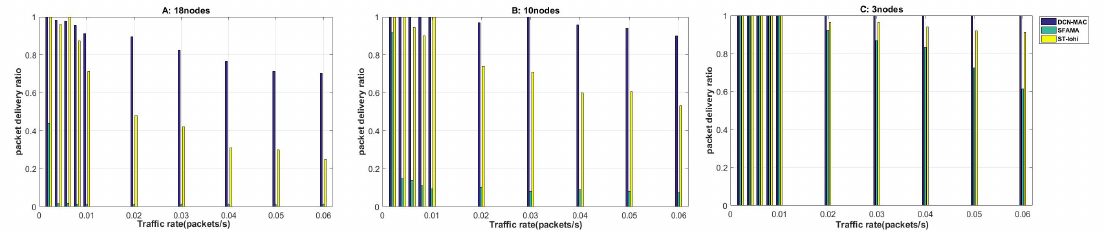
Figure 7. The delivery ratio of the network at different packet generation rates when the number of nodes is 3, 10, and